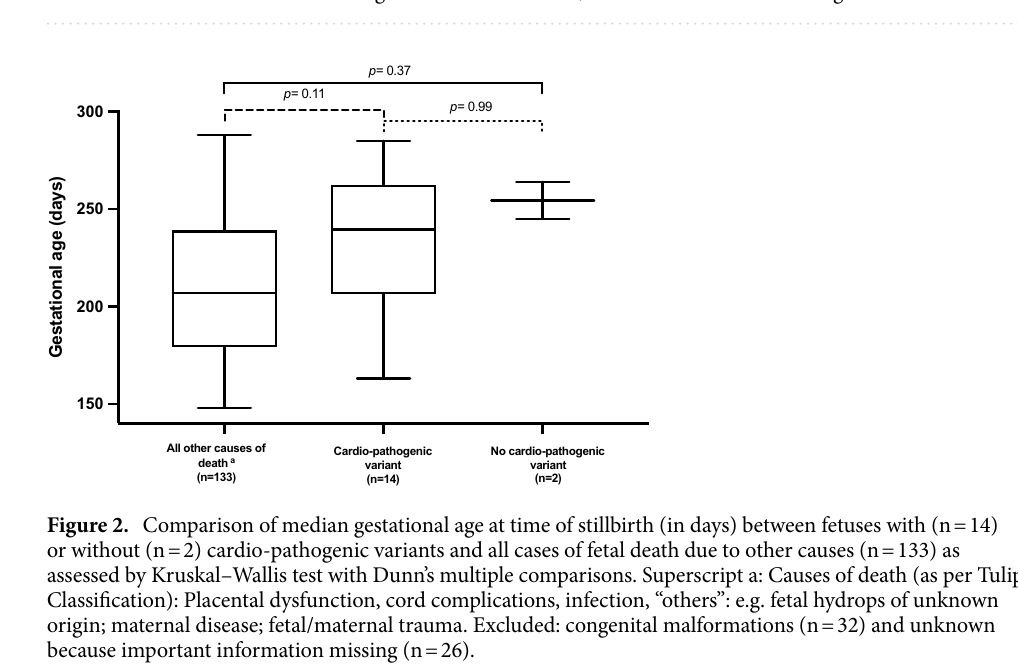
Table 1. Summary of the 33 variants detected in 22 genes in 14 cases of otherwise unexplained intrauterine fetal demise. ACMG American College of Medical Genetics, VUS variant of uncertain significance.